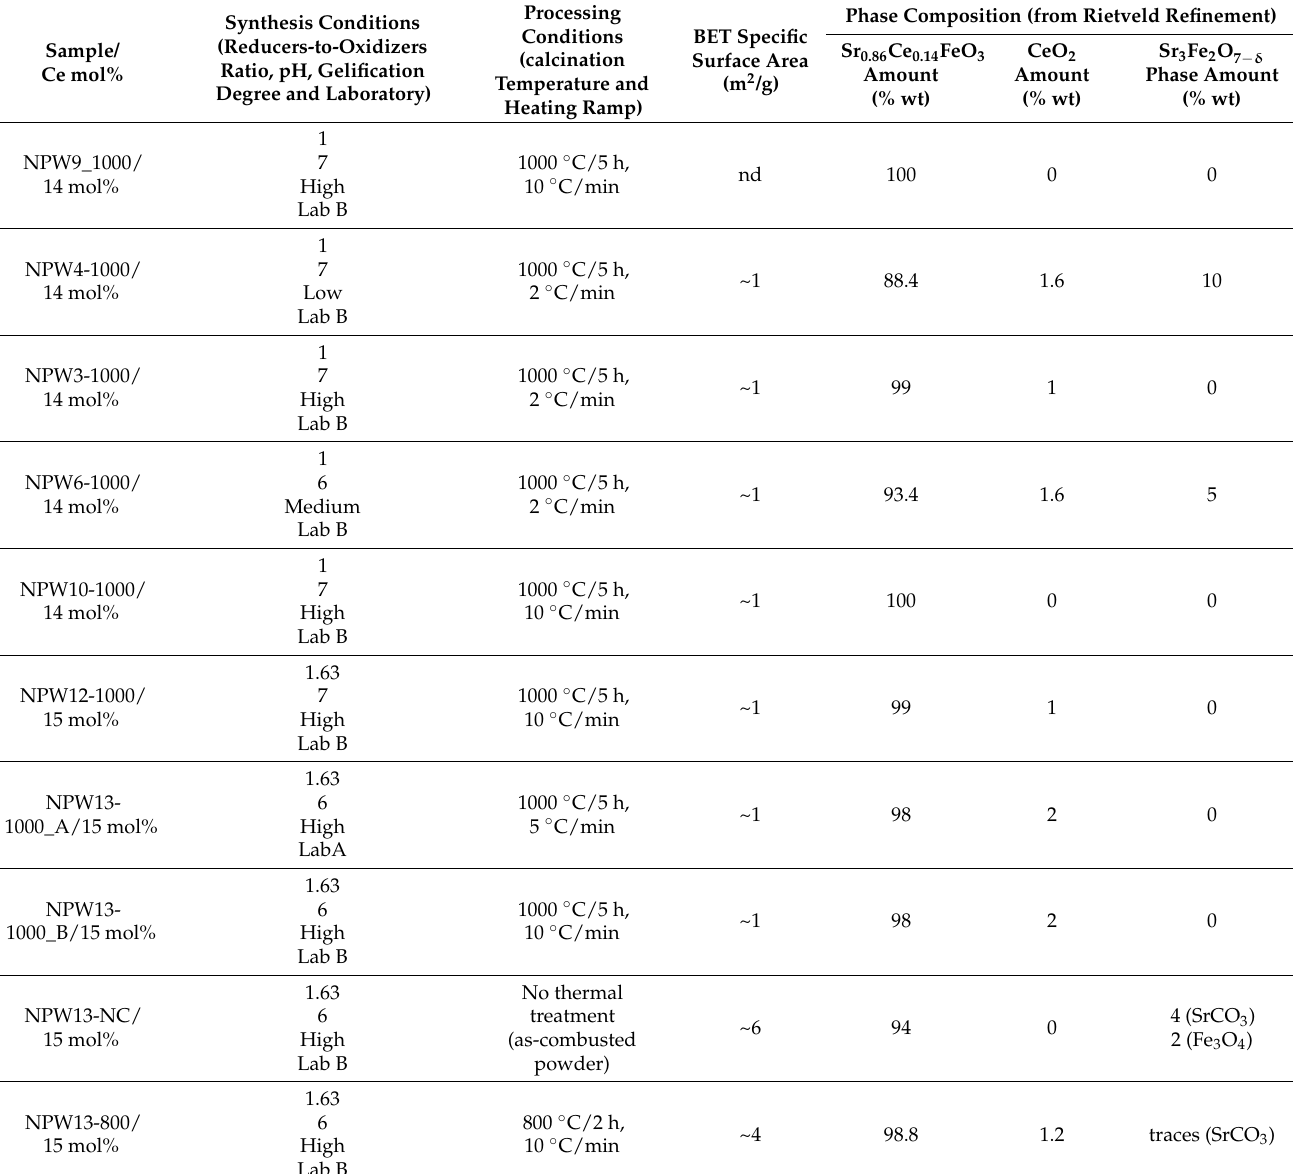
Table 2. Details of the synthesis condition and relevant chemical–physical features of the investigated Ce-doped SrFeO 3